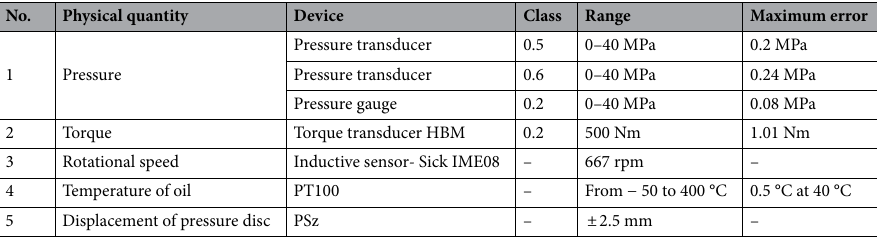
Table 3. Transducer used during experiments.